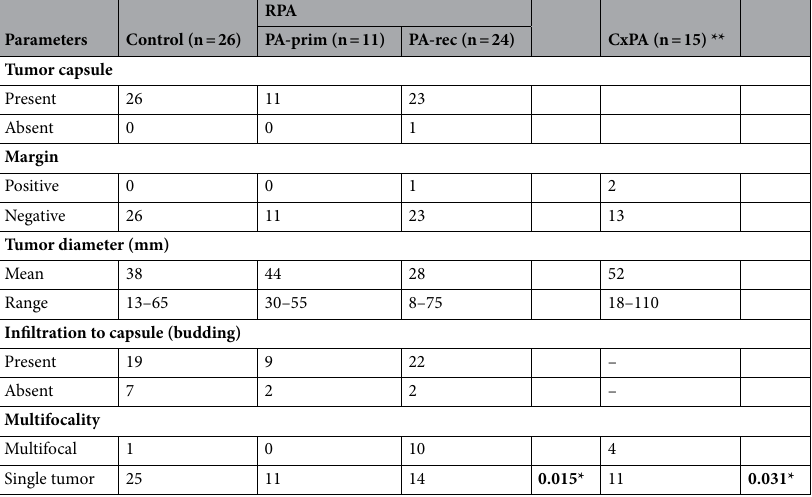
Table 3. Tumor-related information in the investigated groups. *Pearson- chi square, Asymp. Sig. (2-sided). Bolded value is statistically significant ( p < 0.05). ** Ruptured capsule and/or tumor budding were not present or measured due to the tumor invasion. RPA = Patients with recurrent pleomorphic adenoma. CxPA = Patients with carcinoma ex pleomorphic adenoma. PA-prim = Primary tumors of RPA patients. PA-rec = Recurrent tumors of RPA